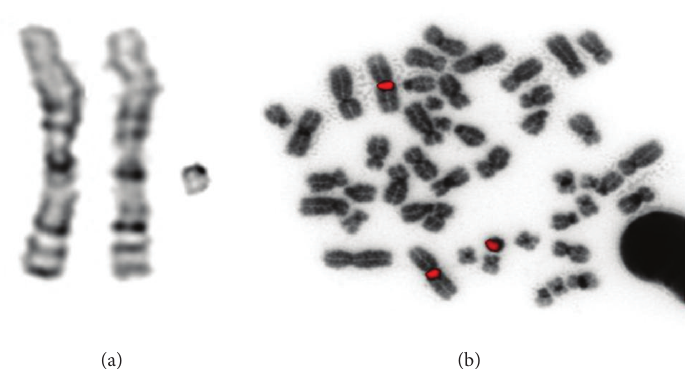
Figure 3: Partial G-banded karyogram showing both normal chromosomes 1 and the supernumerary der(1)(:q10 → q23.3:) (a) and a metaphase after FISH using a satellite III DNA-probe (Vysis) showing three signals on band 1q12